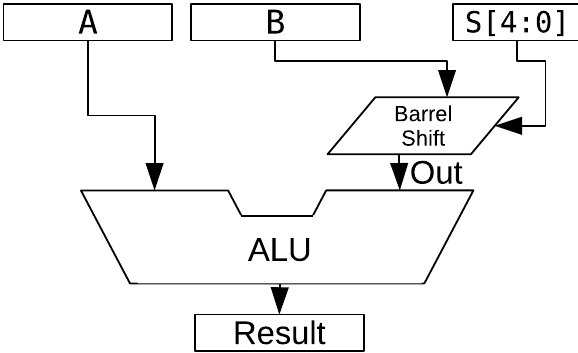
Figure 1: A simplified block diagram of the ARM ALU, showing the operand being fed to a barrel shifter before reaching the